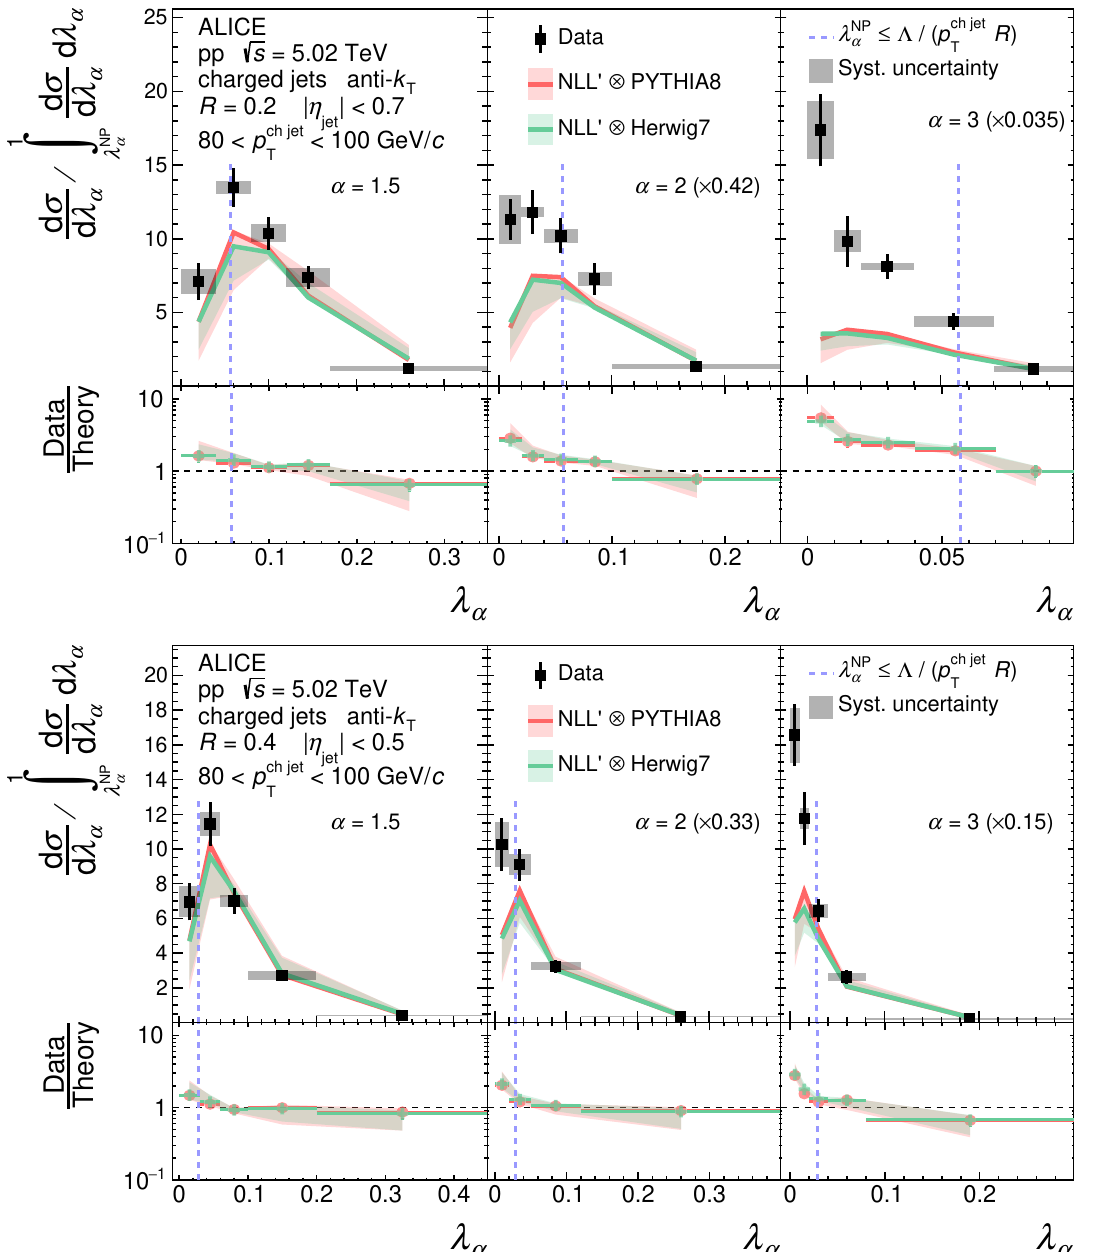
Figure 9 . Comparison of ungroomed jet angularities λ α in pp collisions for R = 0 . 2 (top) and R = 0 . 4 (bottom) to analytical NLL 0 predictions with MC hadronization corrections in the range 80 < p ch jet < 100 GeV /c . The distributions are normalized such that the integral of the perturbative T region defined by λ α > λ NP (to the right of the dashed vertical line) is unity. Divided bins are α placed into the left (NP)